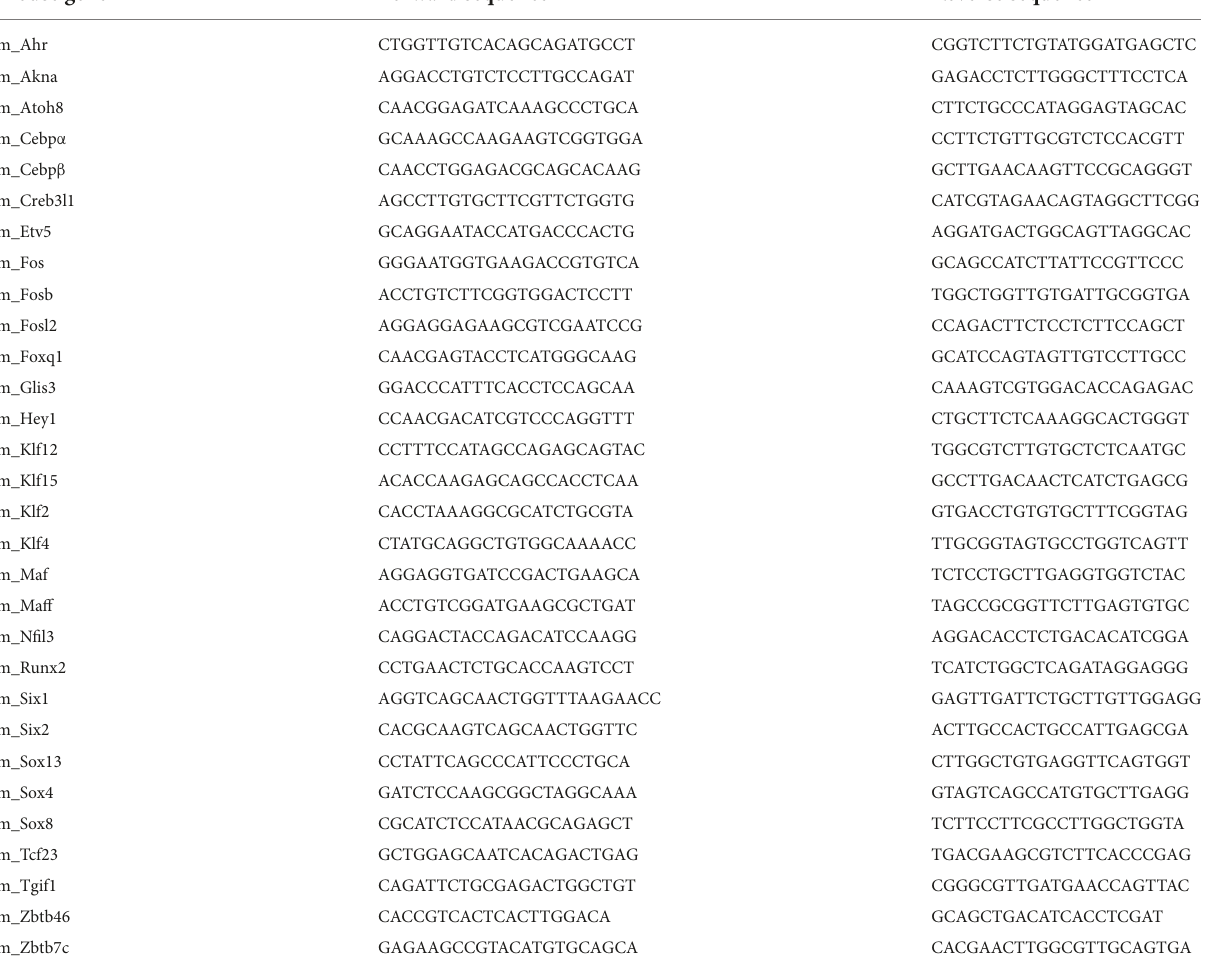
TABLE 1 Mouse qPCR primer